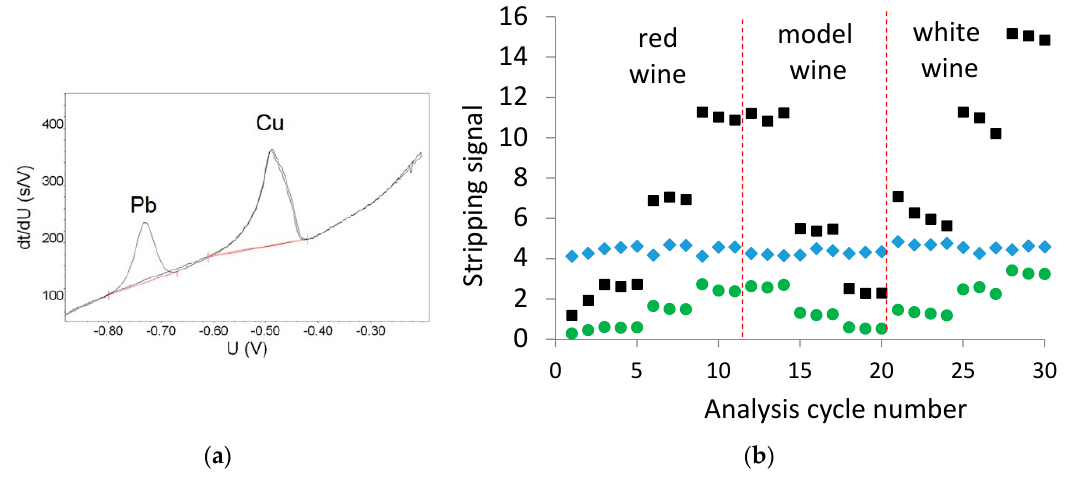
Figure 1. Pb as an internal standard: ( a ) potentiogram of 0.080 mg/L Cu in model wine with and without 2.0 mg/L Pb in the ethanol-based washing solution; ( b ) Cu ( ■ ), Pb ( ♦ ) and the normalized Cu ( ● ) stripping signals obtained during the analysis of red, white, and model wines on a single electrode. The order of analysis is red wine with additions of 0, 0.040 and 0.080 mg/L Cu; model wine with additions of 0.080, 0.040, and 0.020 mg/L Cu; and the white wine with additions of 0, 0.040 and 0.080 mg/L Cu.